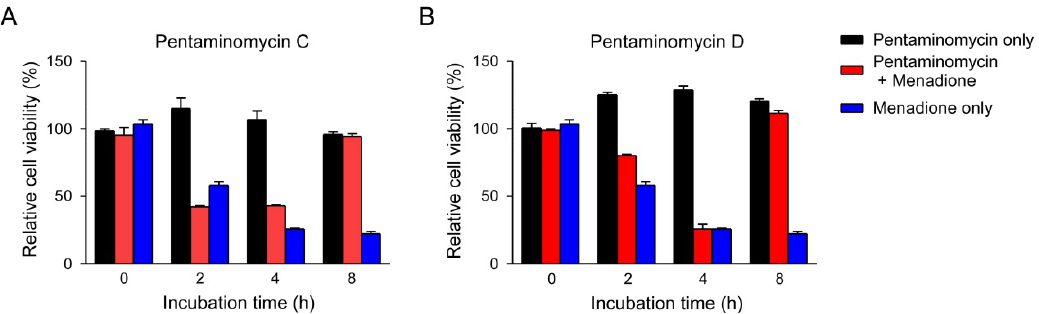
Figure 5. Alleviation of menadione-mediated cytotoxicity by ( A ) pentaminomycin C and ( B ) pentaminomycin D. Oxidative stress was induced by menadione (25 μM) for the indicated time periods in HEK293 cells, which were cotreated with either pentaminomycin C or D. The relative cell viability was assessed using the CellTiter-Glo assay and the values are represented as mean ± SD ( n = 3).